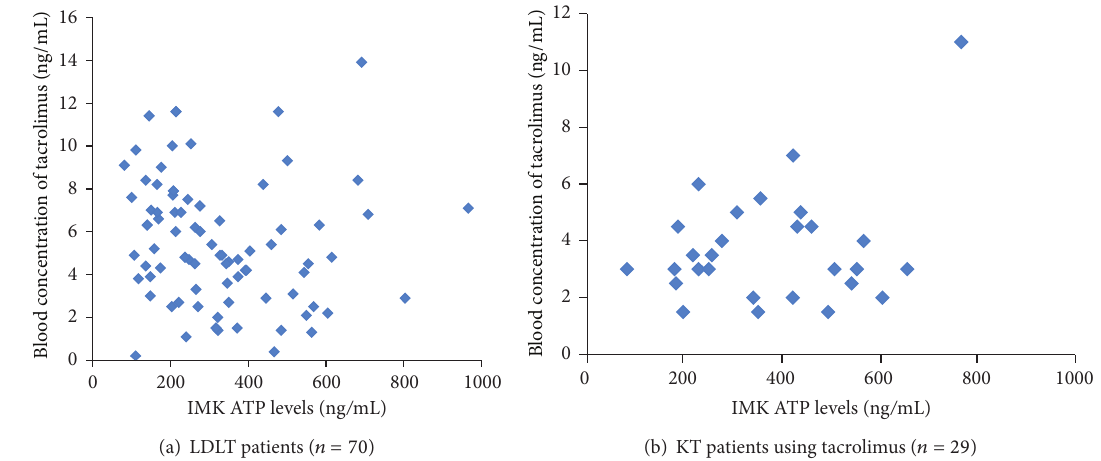
Figure 2: Relationship between blood concentration of tacrolimus and IMK ATP levels. There was also no statistically significant relationship between the blood concentrations of tacrolimus and the IMK ATP levels in LDLT recipients ( 𝑅 = 0.147 , 𝑃 = 0.181 ) (a) and in KT patients who used tacrolimus ( 𝑅 = 0.284 , 𝑃 = 0.2745 )